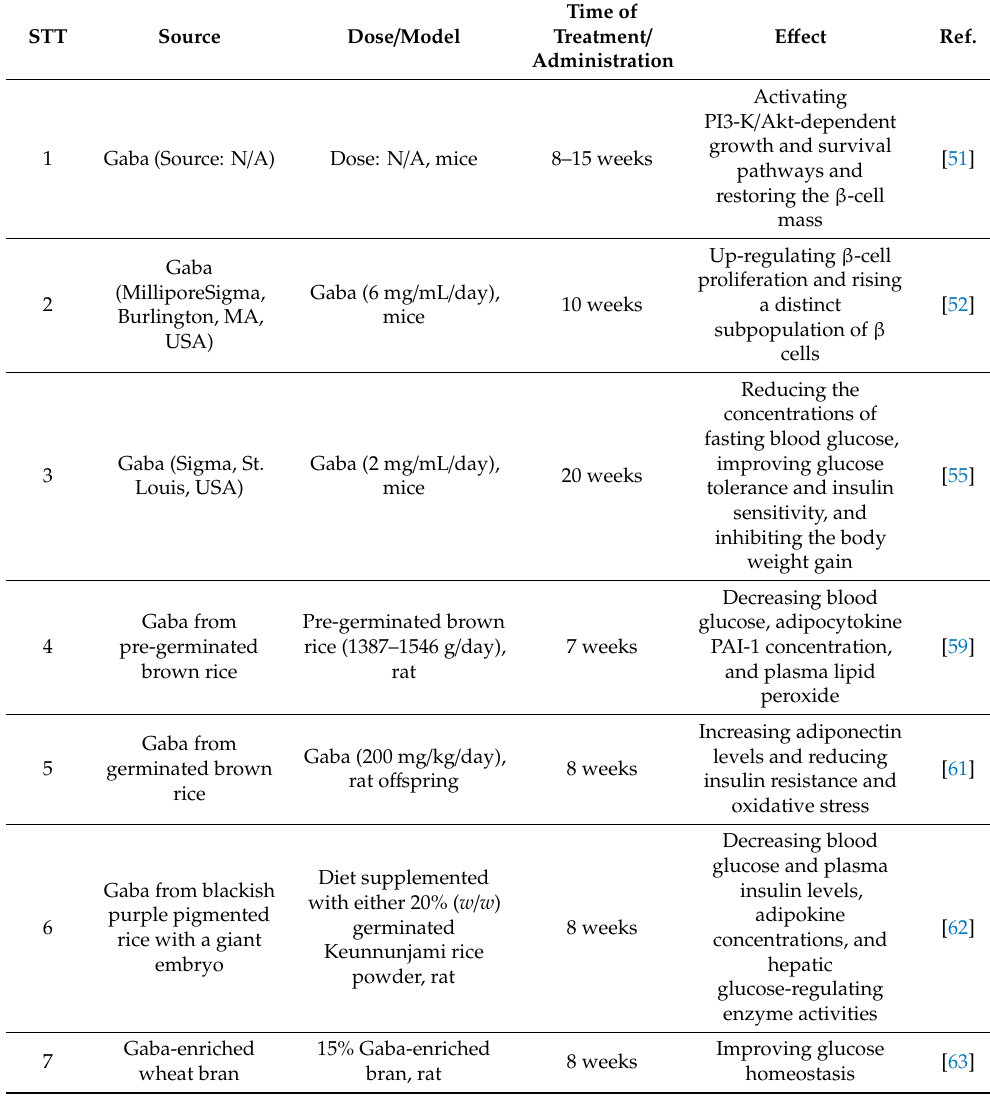
Table 4. Anti-diabetic e ff ect of